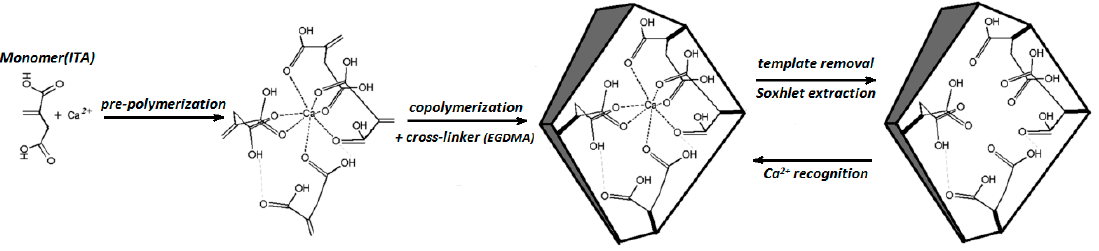
Figure 10. Schematic representation of Ca +2 -IIP method.